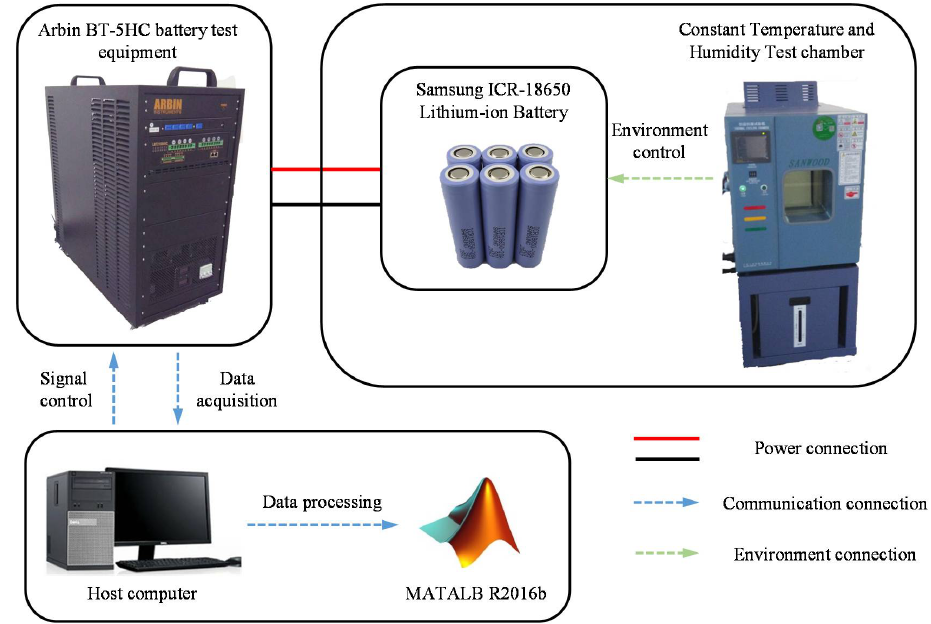
Figure 3. Structure of battery test bench.